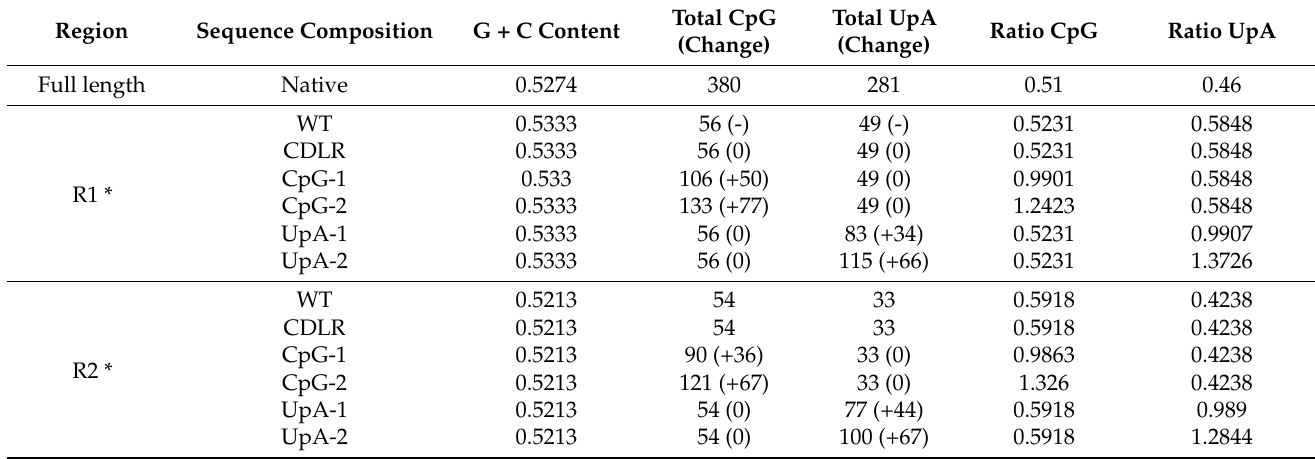
Table 1. CpG and UpA dinucleotide composition in recoded regions of